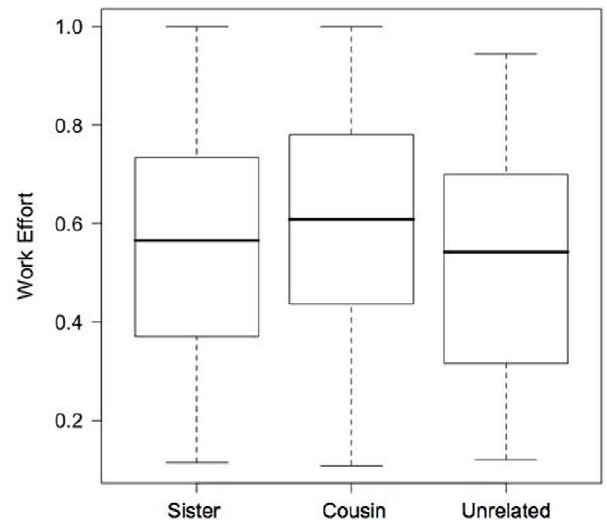
Figure 4. Foraging effort of sisters, cousins and non-relatives of the dominant wasp. Foraging effort is estimated based on proportion of time spent away from the nest.